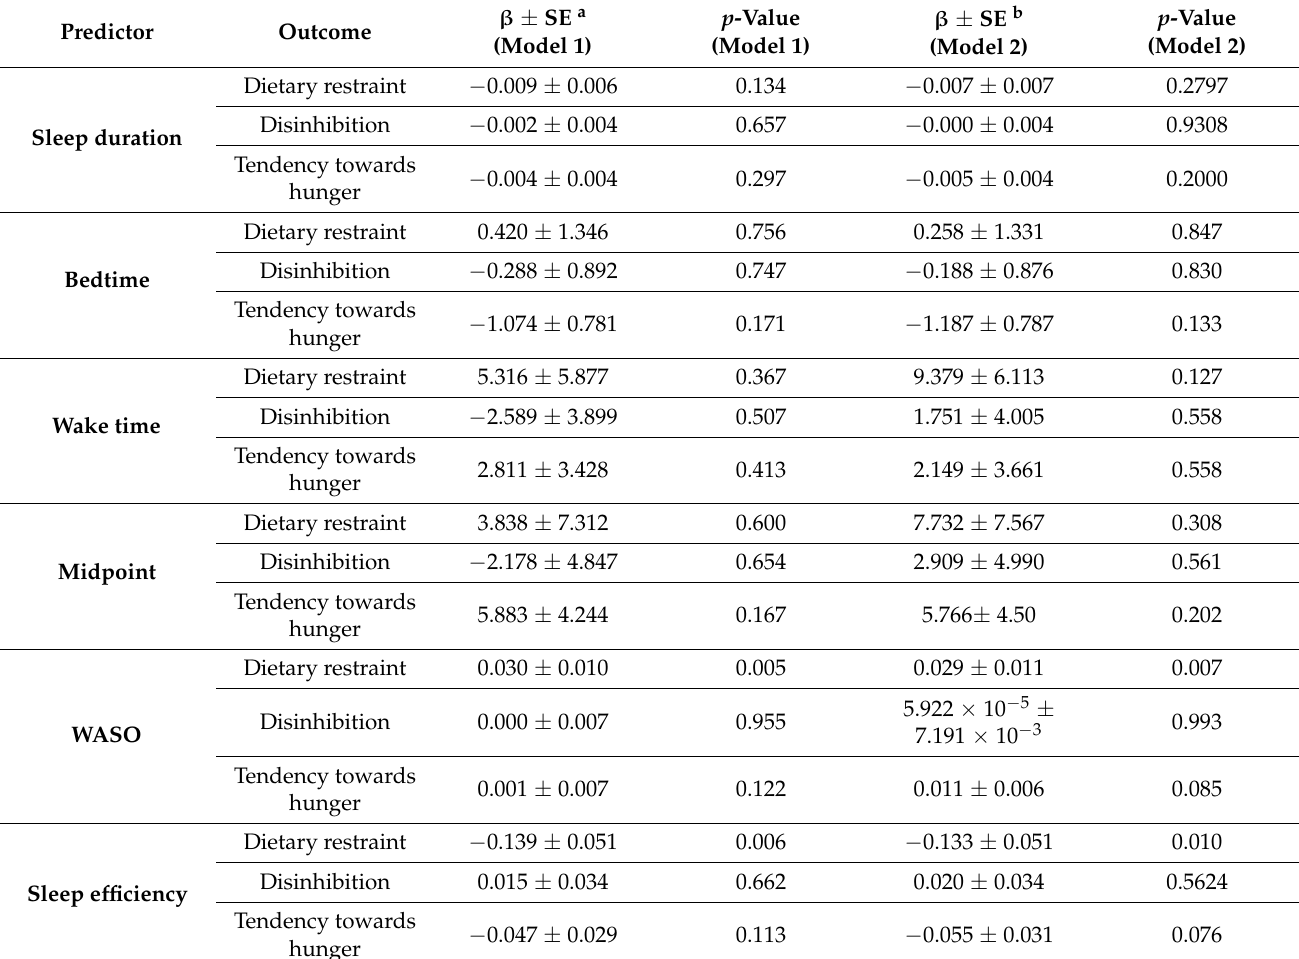
Table 2. Cross-sectional analysis of measures of day-to-day sleep variability with eating behavior